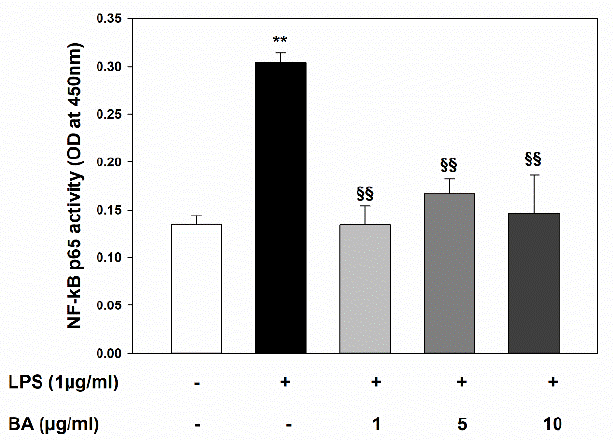
Figure 4. Inhibitory effect of BA on LPS-induced NF- κ B p65 activation in HT-29 cells. Cell cultures were treated with BA that was added to culture medium 30 min before incubation with LPS for 4 h. NF- κ B p65 activation was determined by ELISA performed on nuclear extracts. ** p < 0.01 significant differences vs. Ctr; §§ p < 0.01 significant differences vs. LPS treated cells.